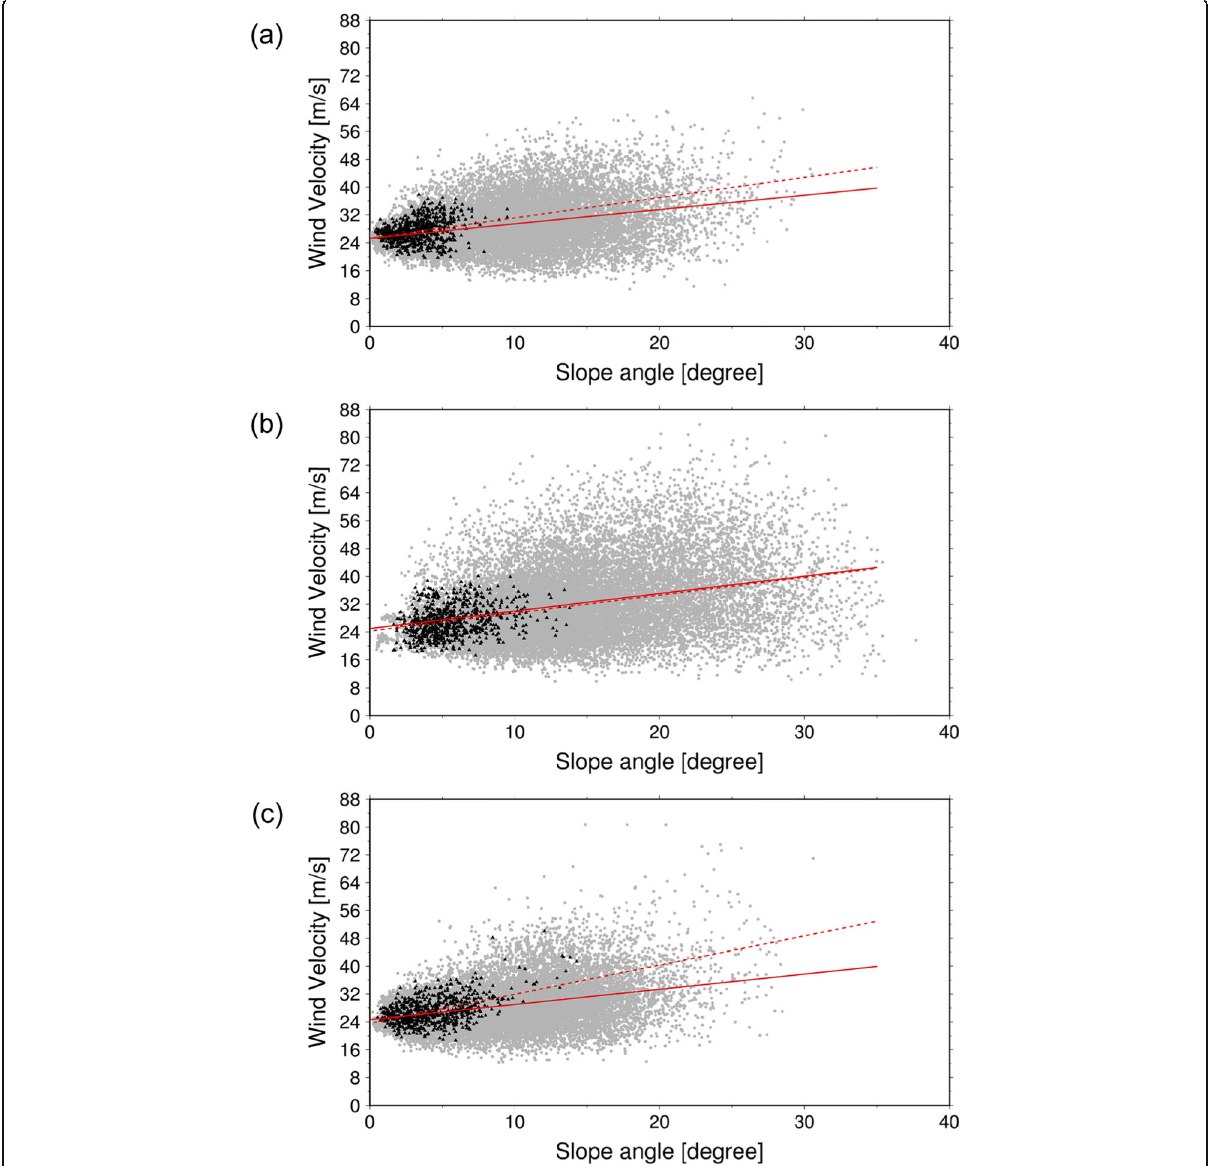
Fig. 7 Relationships between terrain slope and maximum wind speed in the analysis areas. The same as Fig. 6, except for the maximum wind speed during the simulated time